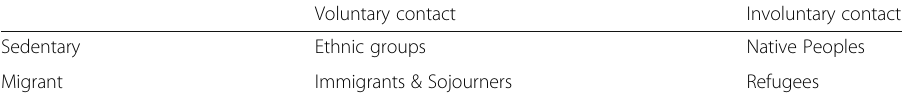
Table 1 The mobility and voluntariness of contact with natives of different